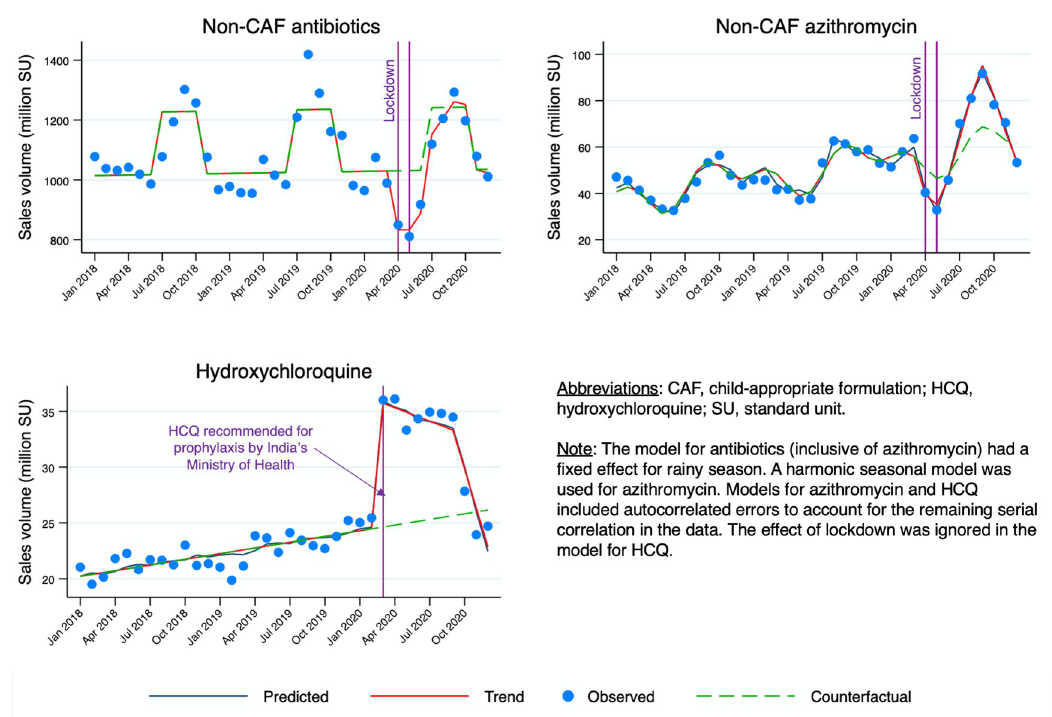
Fig 4. Results of segmented regression analysis for monthly sales volumes of non-CAF antibiotics, azithromycin, and HCQ between January 2018 and December